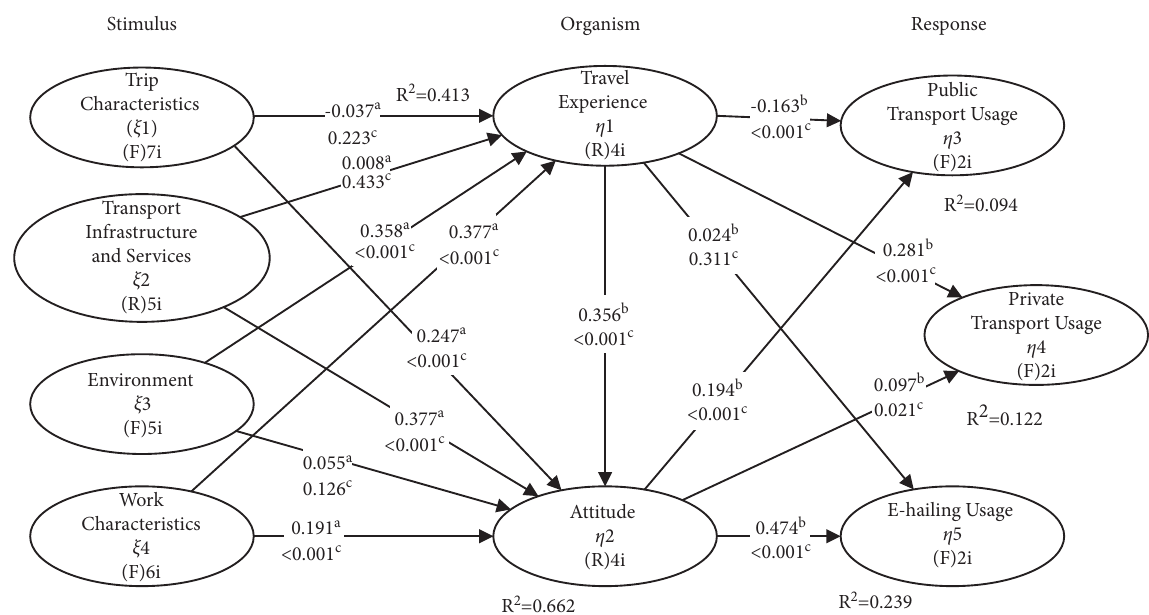
Figure 3: The structural model. Note: a path coefficients ( c ); b path coefficients ( β ); c p value; and GoF index �